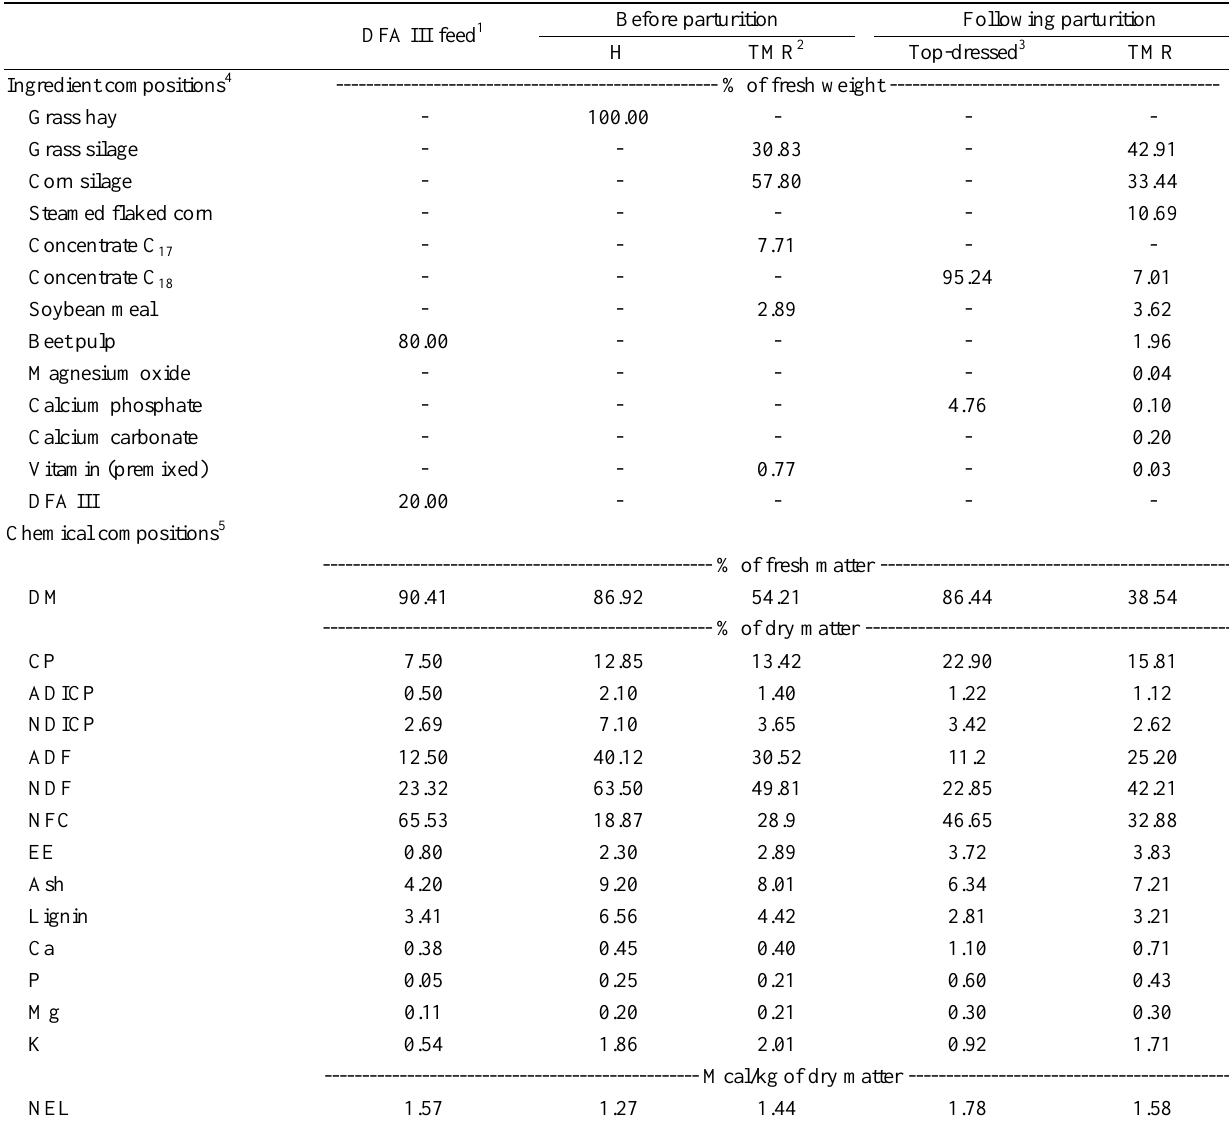
Table 1. Ingredient and chemical compositions of DFA III feed and other basal